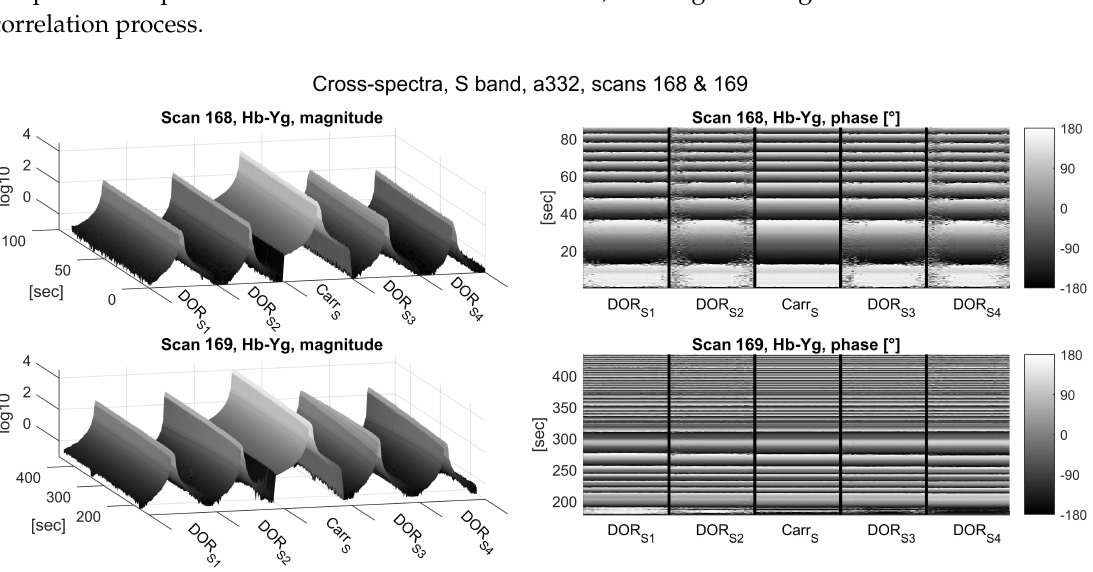
Figure 6. Cross-spectrum magnitudes (left column) and phases (right column) of the S-band zoom-bands of Scans 168 (upper panels) and 169 (lower panels) of Experiment a332. The frequency axes (horizontal axes) depict the five 32 kHz wide DiFX zoom-band described in Table 3 next to one another. The time axes indicate seconds since the start of Scan 168 (10:41:04